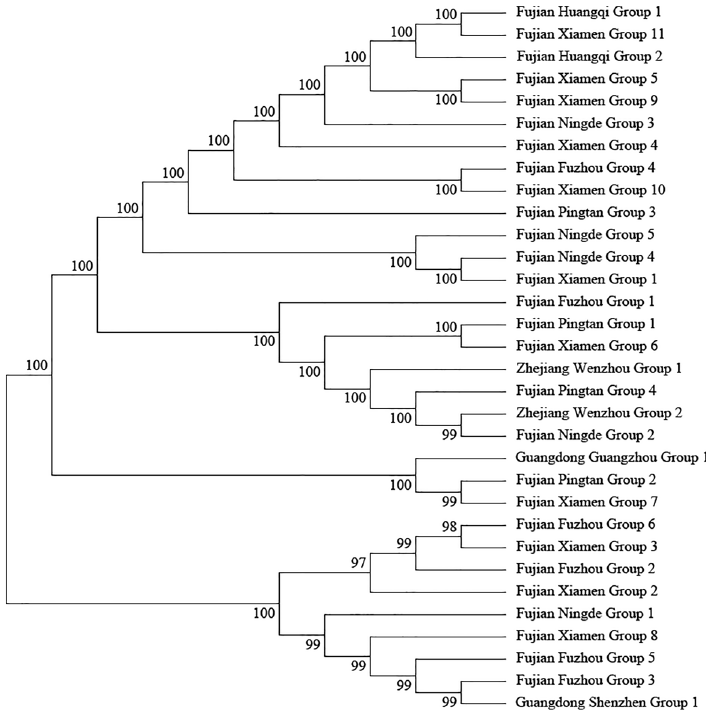
Figure 8. Phylogenetic tree of S. lepifera